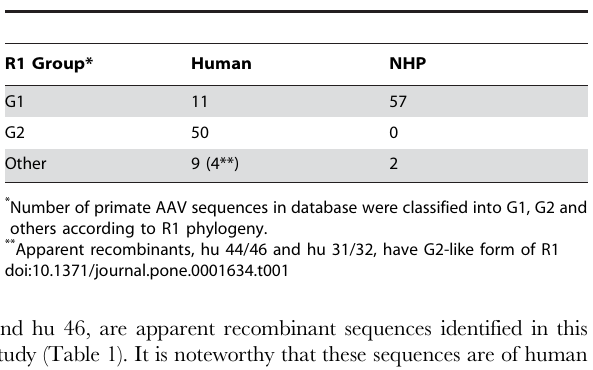
Table 1. Host distribution of G1/G2